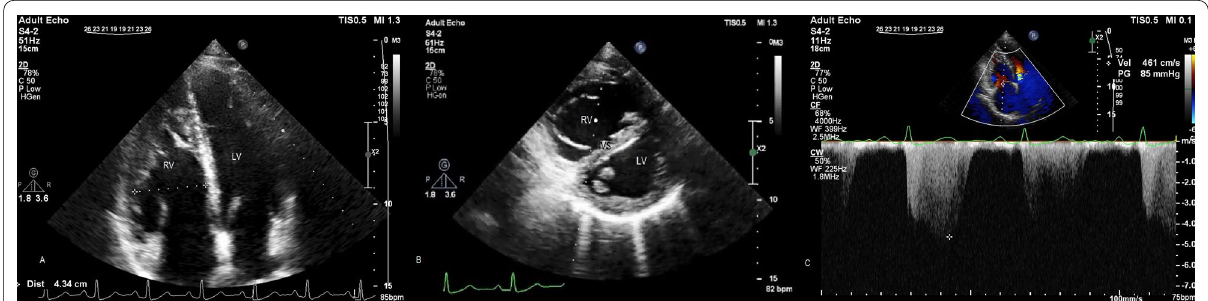
Fig. 2 Echocardiogram showing right ventricular enlargement ( A ), septal flattening in systole and diastole in favor of right ventricular pressure overload ( B ), and high tricuspid regurgitation gradients ( C ). RV right ventricle, LV left ventricle, IVS inter‑ventricular